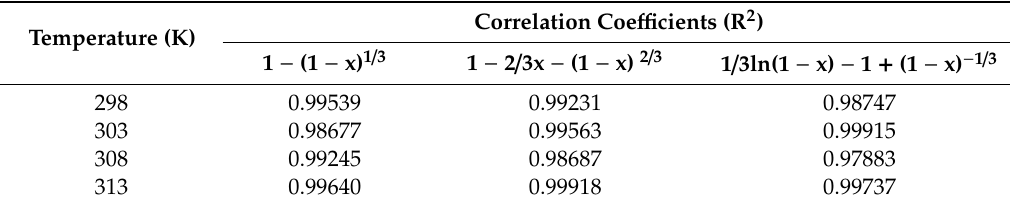
Table 2. Correlation coe ffi cient of di ff usion control and interface chemical reaction control at di ff erent temperatures under conventional conditions.